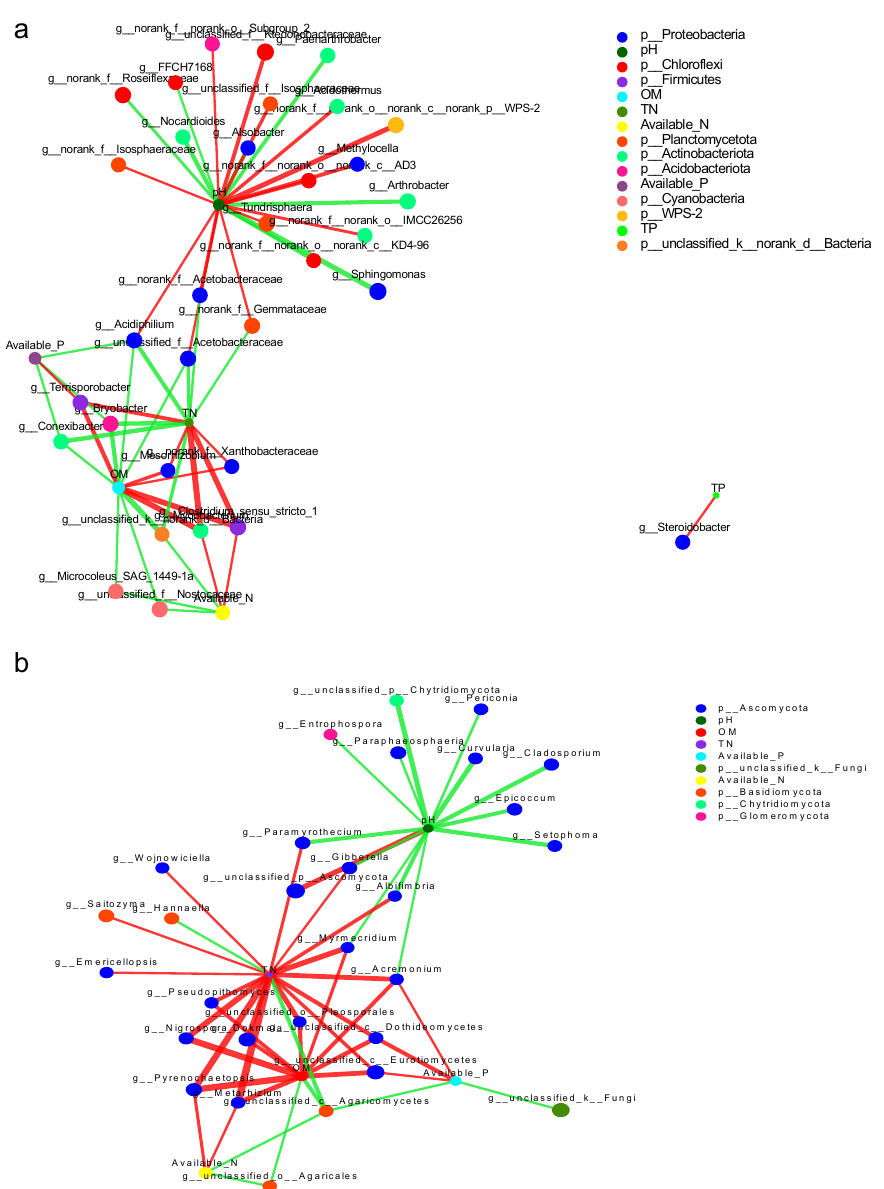
Figure 9. Microorganism and soil characteristics co-occurrence networks in moss-dominated biocrusts soils. ( a ) Co-occurrence network of bacteria. ( b ) Co-occurrence network of fungi. Positive interactions are depicted as red edges and the negative interactions are depicted as green edges.